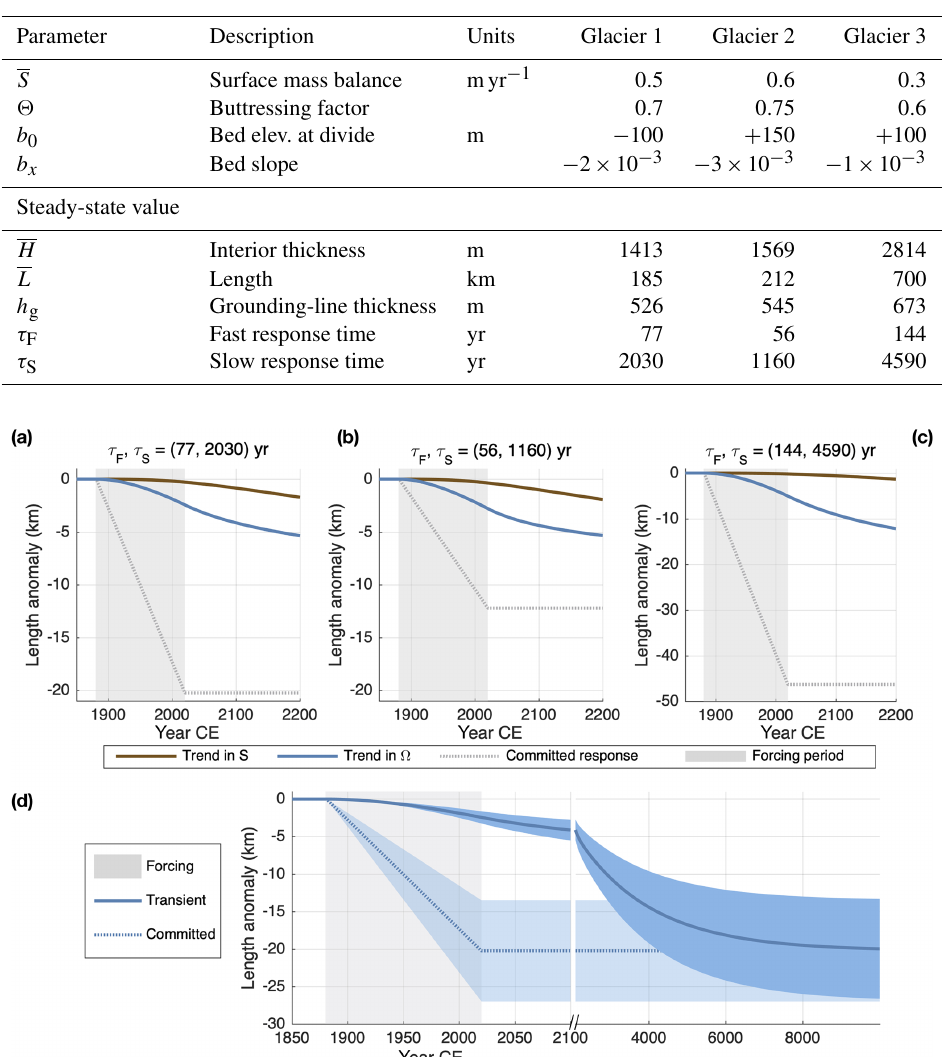
Table 2. Parameters varied between three idealized glaciers (top) and the resulting steady-state values (bottom). The steady state is calculated by the nonlinear two-stage model, and the linearized response times are given by Eqs. (13) and (14).